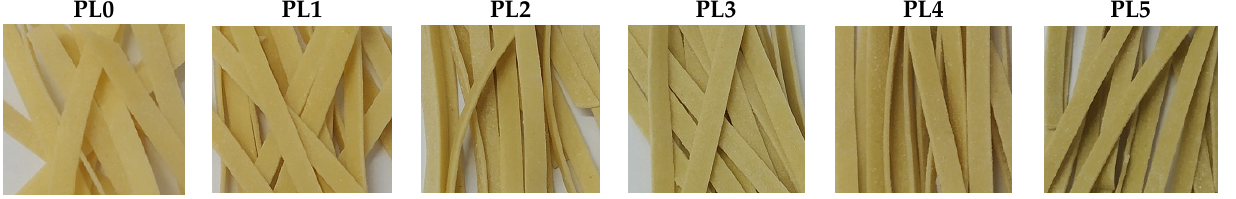
Figure 2. Pasta enriched with GL. PL0, PL1, PL2, PL3, PL4, and PL5 denote pasta with 0, 1, 2, 3, 4, and 5 g/100 g of green leek, respectively.